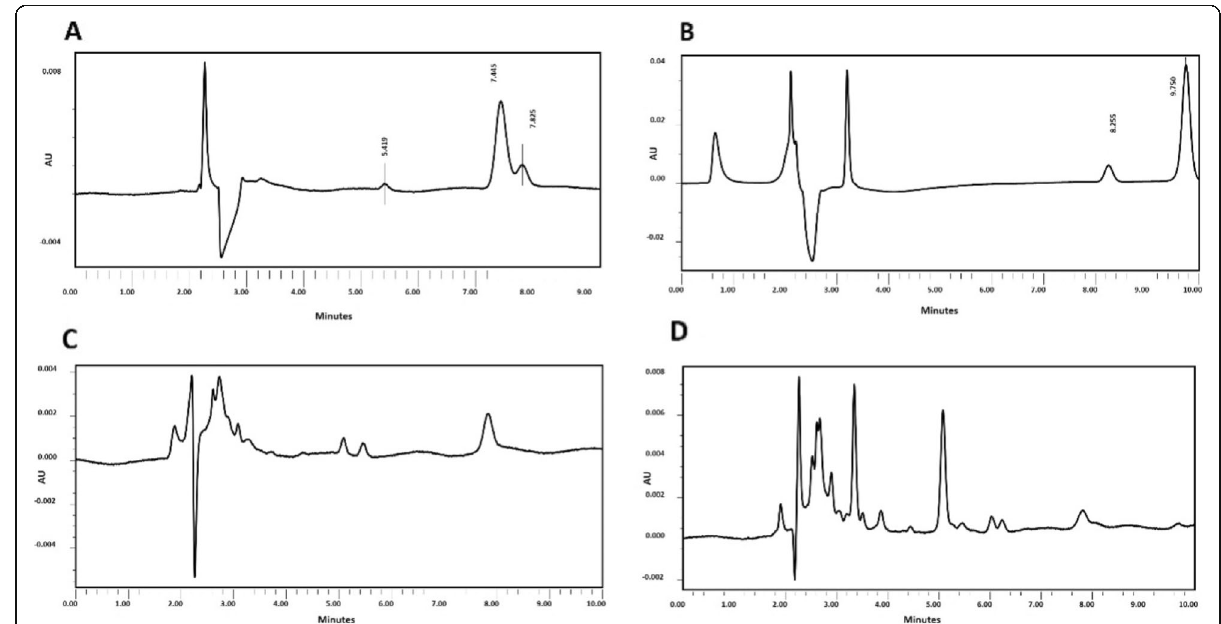
Fig. 4 Accelerated degradation study representing BQF degradation behaviour in 0.5 N HCl ( a ), 0.5 N NaOH ( b ), 0.01 N HCl exposed to direct sunlight ( c ), methanol exposed to direct sunlight ( d